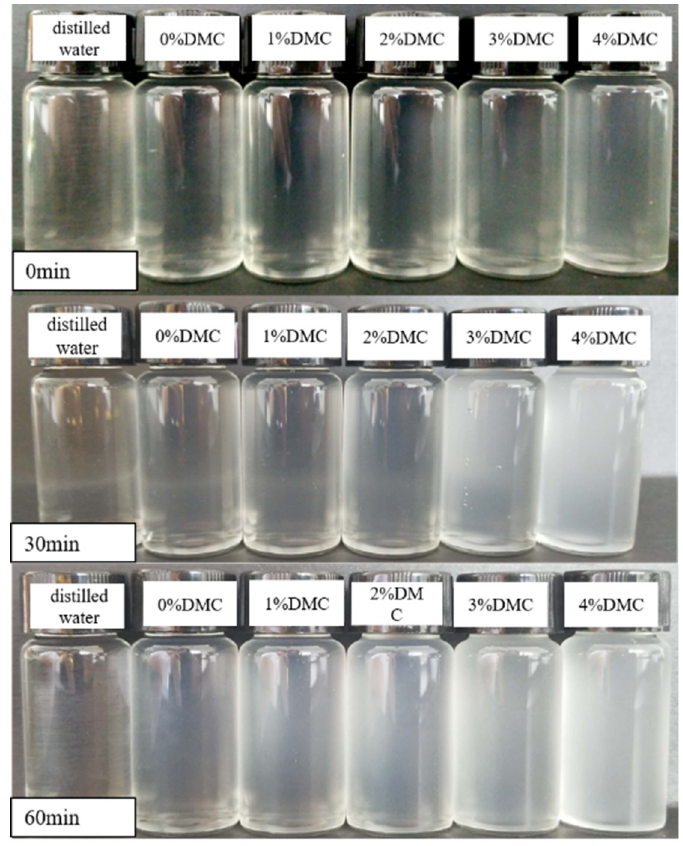
Figure 3. Photography of di ff erent concentrations of the solution under di ff erent ultrasound.